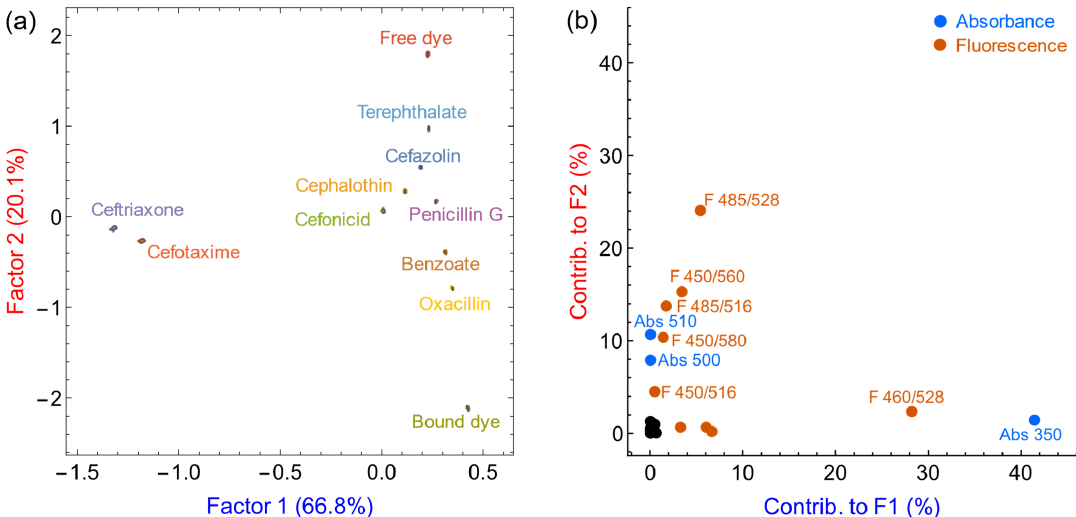
Figure 5. LDA results for qualitative discrimination of nine analytes (two penicillins, five cephalosporins and two reference carboxylates) using [calcein•PAMAM] sensor and hydrolytic sample pre-treatment. ( a ) Scores plot; ( b ) loadings plot. Abs: absorbance, F: fluorescence emission λ ex / λ em . The black points correspond to instrumental measurements with very low contributions to both LDA factors; these were mostly fluorescence anisotropy measurements that were later removed in further analyses. Analyte solutions were prepared at pH 10 and then brought back to pH 7.4 for β -lactam ring hydrolysis. [calcein] = 6.36 μ M, [PAMAM G5] = 2.13 μ M, [analytes] = 5.0 mM. Performed in 50 mM aqueous HEPES buffer, T = 25 °C.